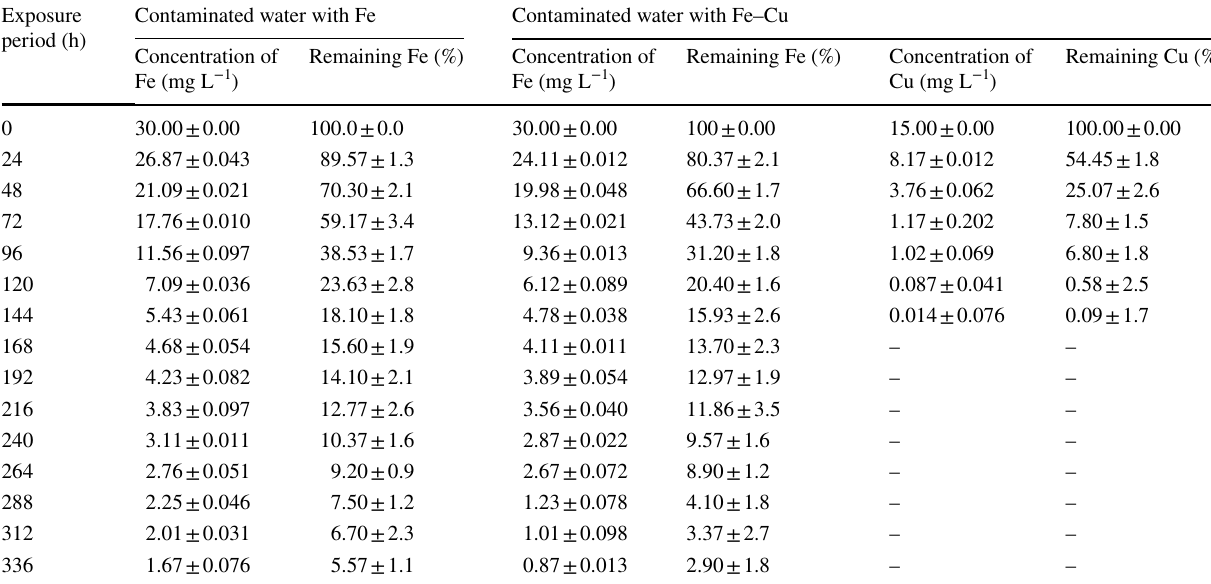
Table 1 Variation of Fe and Cu concentrations in water as a function of exposure period for the Fe and Fe–Cu microcosms (mean ± standard deviation)